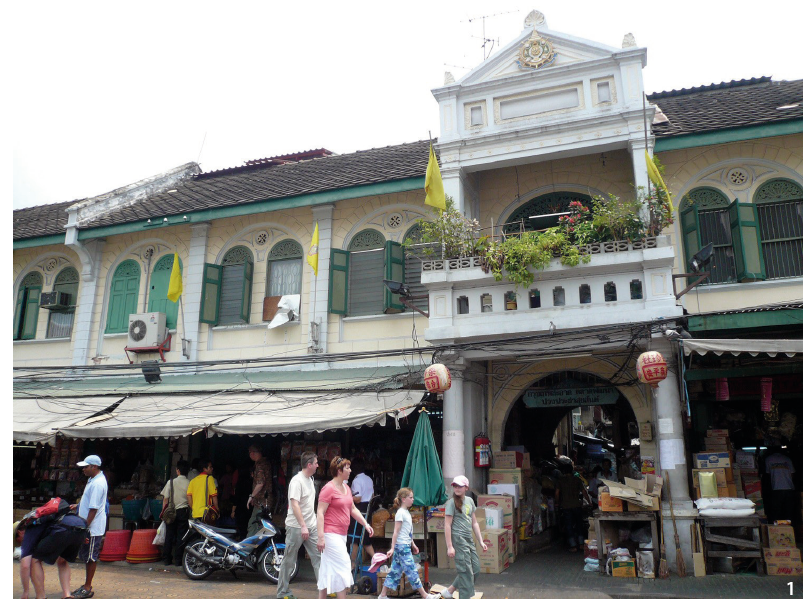
Figure 1 Tha Tien before restoration (Source: T. Sirisrisak).